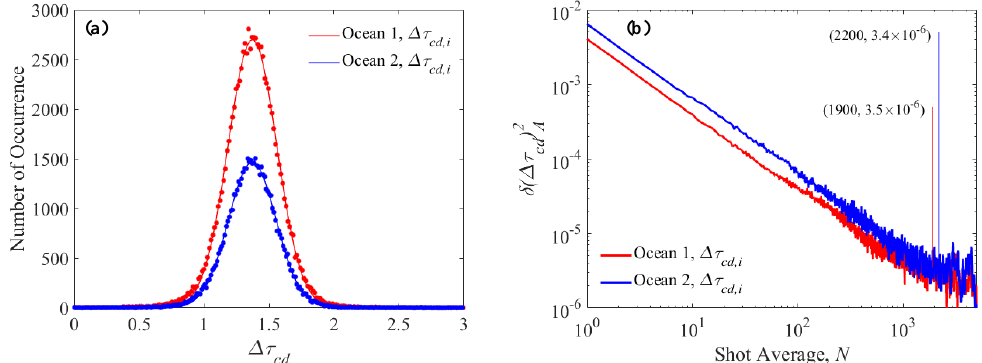
Figure 14. Statistical analysis for the 2-μm IPDA lidar single-shot Δτ cd measurement. ( a ) Statistical distribution of Δ τ cd data (dots) and normal distribution fitting (curves) indicating dominant shot noise. ( b ) Allan-variance analysis for single-shot Δ τ cd confirming shot noise domination, which can be reduced by shot average exceeding the applied 10-s (500 shots).